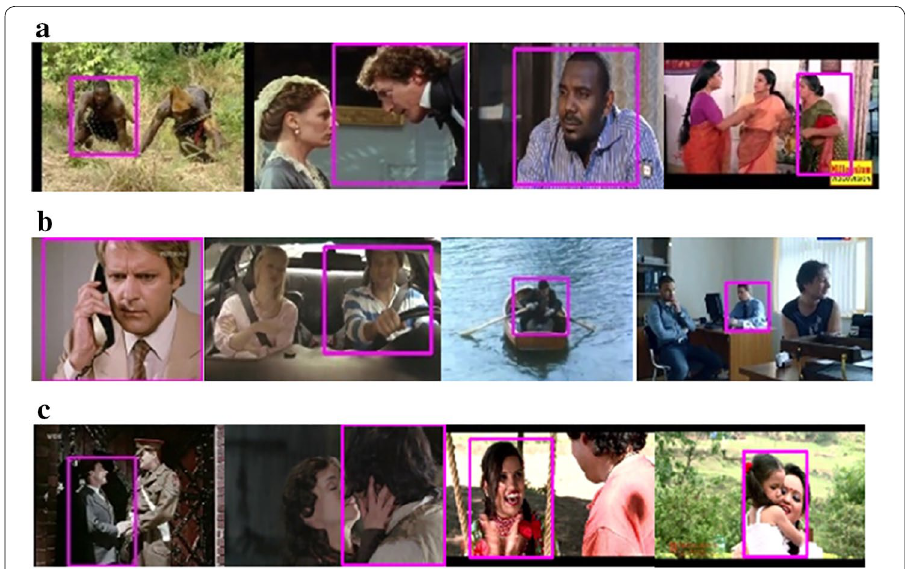
Fig. 8 Human activities from AVA datasets: a human atomic movements (crawl, bend, sit, stand); b human– object interactions (answer phone, driving, row boat, work on a computer) and c human–human interactions (hand shaking, kiss, hand clap, lift a person)